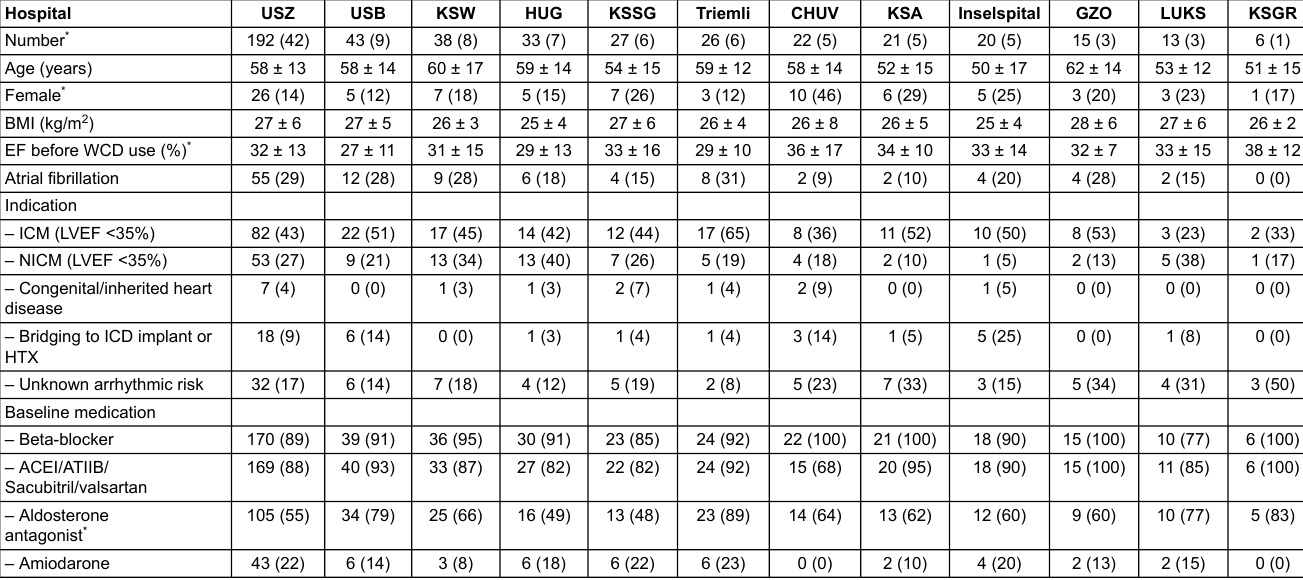
Table 1: Baseline characteristics of the study population.